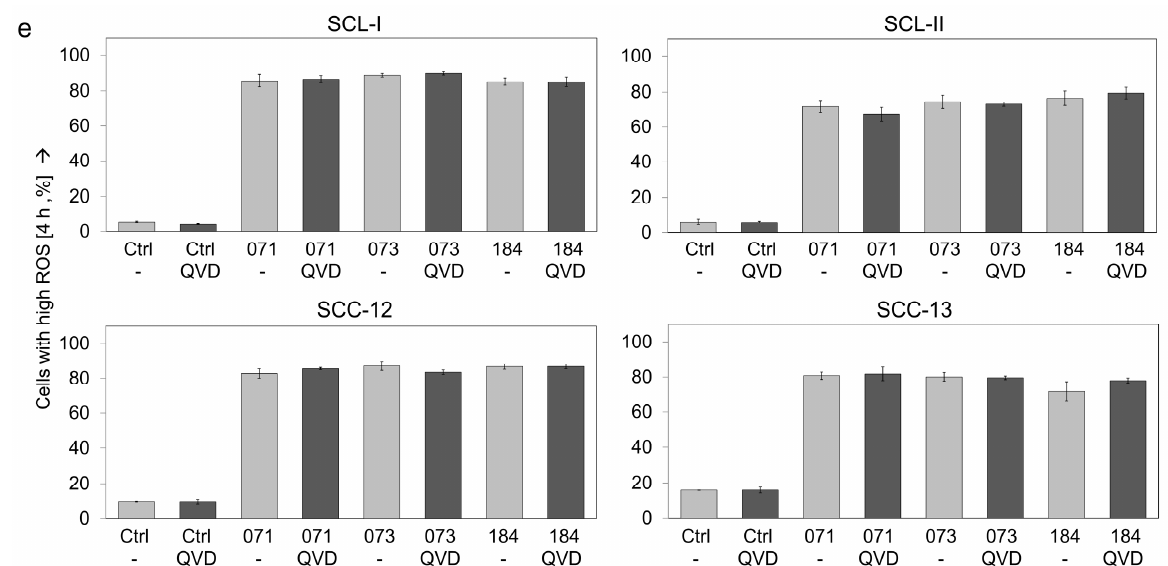
Figure 6. Inhibition of apoptosis by caspase antagonist. The antagonistic effects of the pan-caspase inhibitor QVD-Oph (QVD, 10 µ M, 1 h pretreatment) on indirubins’ antitumor activity are shown. ( a ) Cell viability was determined by calcein- AM staining in SCL-II and SCC-12 at 24 h in response to the combinations of indirubins (DKP-071, -073 and -184, 10 µ M) and TRAIL (TR; 50 ng/mL). ( b ) Apoptotic cells were quantified by cell cycle analyses (propidium iodide staining, flow cytometry) as sub-G1 cells characterized by DNA fragmentation (treatment as above). ( c ) Cell proliferation was quantified by WST-1 assay in SCL-I at 24 h of treatment with indirubins, TRAIL or combinations. ( d ) Loss of MMP was investigated in SCL-I and SCC-12 at 4 h of treatment with indirubins (10 µ M). ( e ) ROS production was investigated in the four cell lines at 4 h of treatment with indirubins (10 µ M). ( a – e ) Mean values and SDs are shown of a representative experiment (two independent experiments, each one with triplicates). Asterisks indicate statistical significance, when cells ± QVD-Oph were compared (** p < 0.01; *** p <